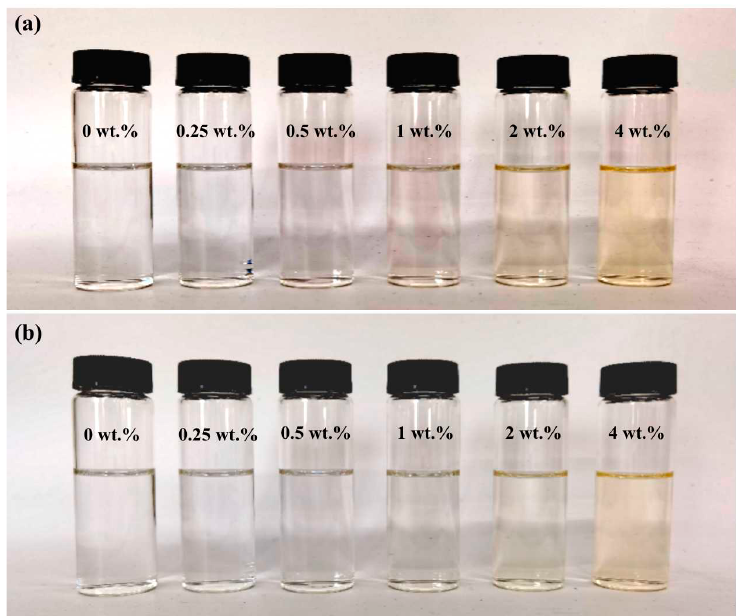
Figure 4. The JD2000 aqueous solutions with different concentrations with standing time of: ( a ) one day; and ( b ) one month.